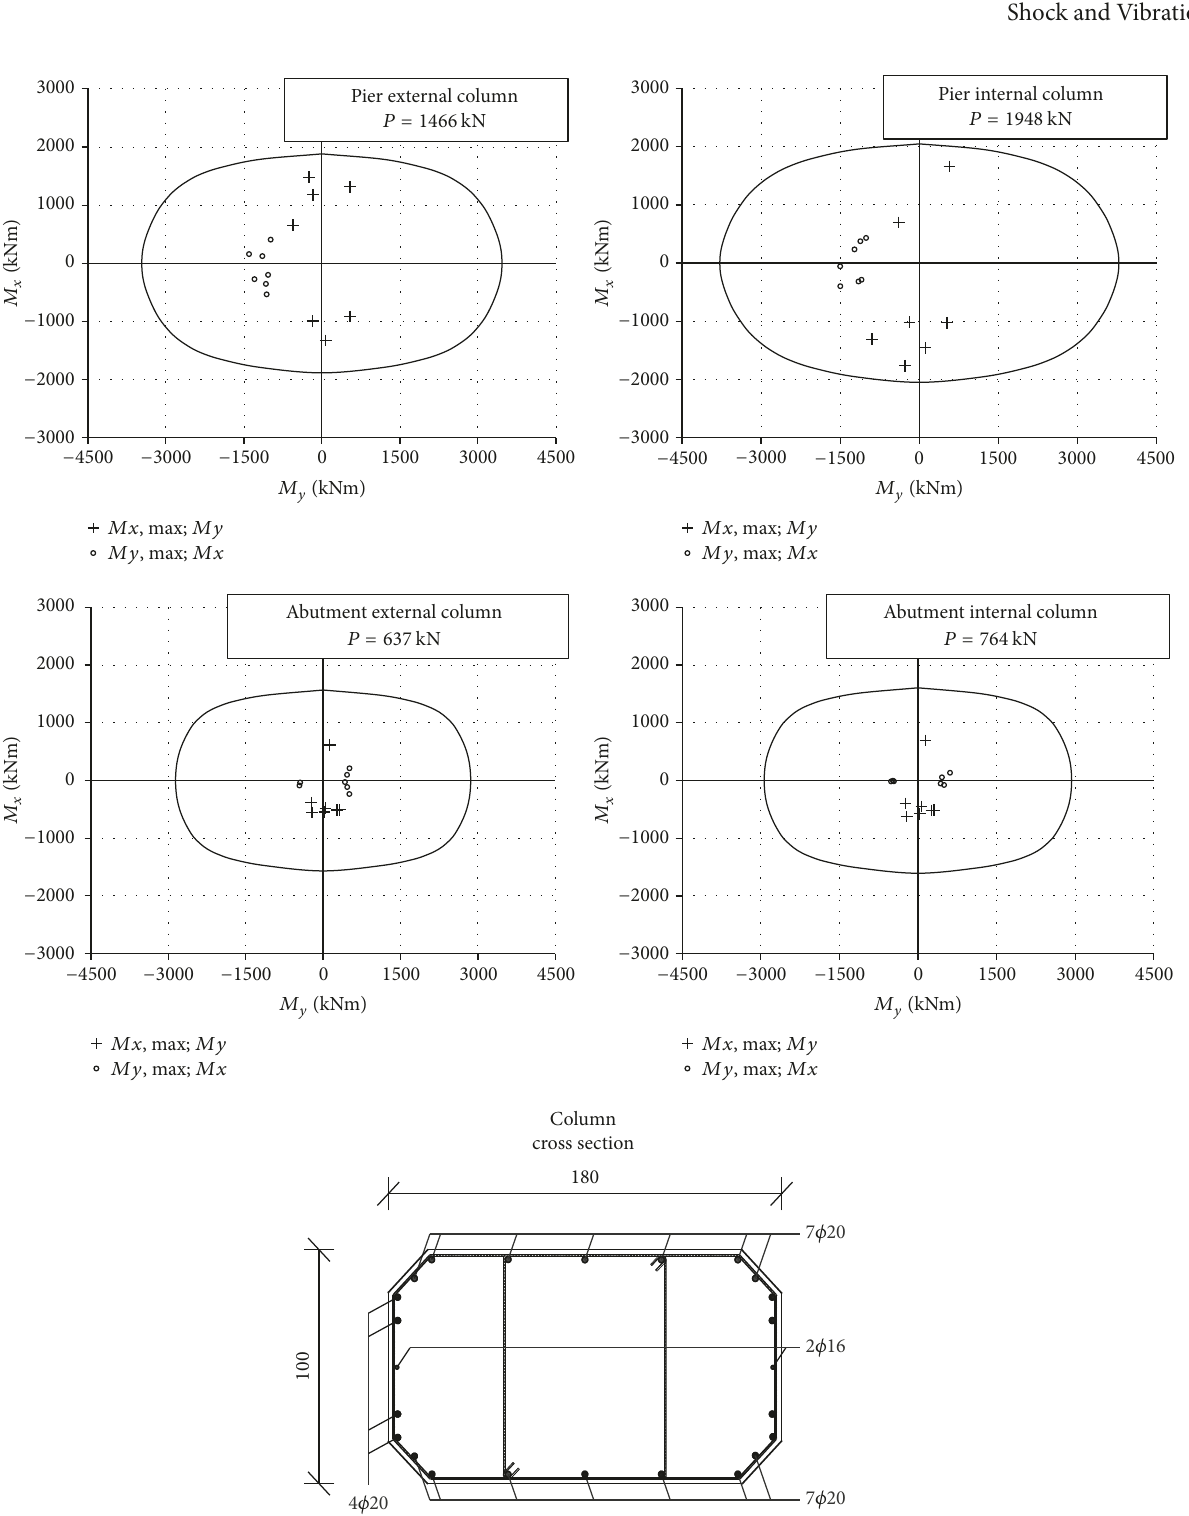
account in order to carry out an accurate seismic response assessment of a seismically isolated bridge. On the other hand, the rate parameter has shown only a slight impact on the structural response parameters. In particular, the effect of